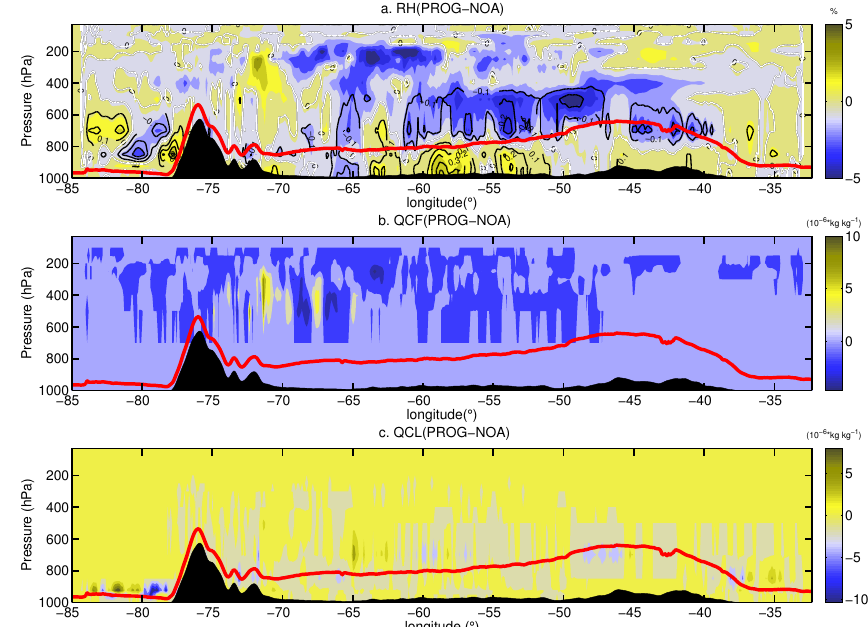
Figure 7. As in Fig. 6 but differences are for (a) relative humidity (coloured), black contours are specific humidity (gkg − 1 ), (b) ice cloud water (QCF) and (c) liquid cloud water (QCL). The red line is boundary layer depth of PROG. Topography is masked in black.